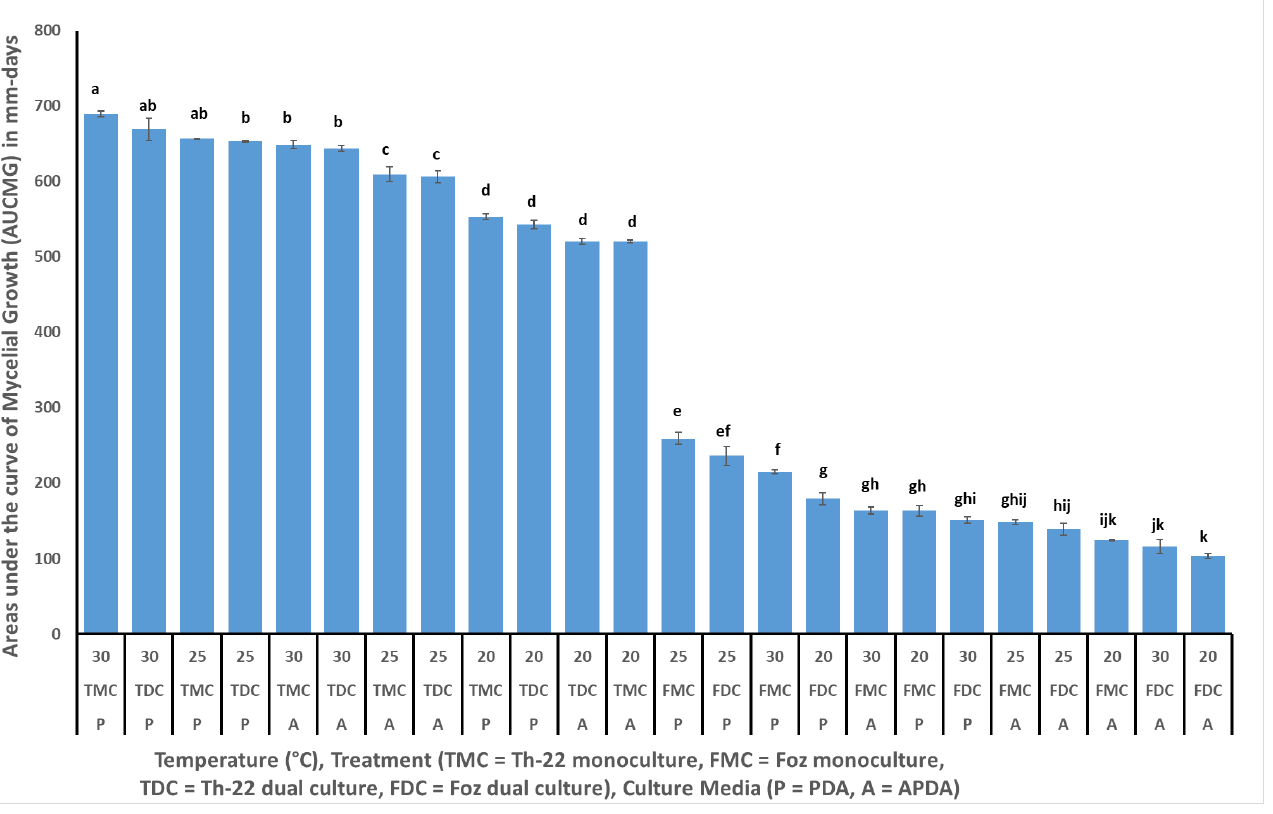
Figure 3. Areas under the mycelial growth curve (AUMGC) of the pathogen Fusarium oxysporum f.sp. zingiberi (Foz) and the beneficial fungus Trichoderma harzianum (Th-22) in mono- or dual culture laboratory studies plated on potato dextrose agar (PDA) or acidified PDA (APDA) media and incubated at 20 °C, 25 °C or 30 °C. Result from interaction of three factors, i.e., Temperature × Treatment × Culture Media is presented after a significant p -value = 0.0008 using Proc GLIMMIX procedure in SAS. Means that do not share the same letter on top of the bars are significantly different according to Tukey’s test at p < 0.05.